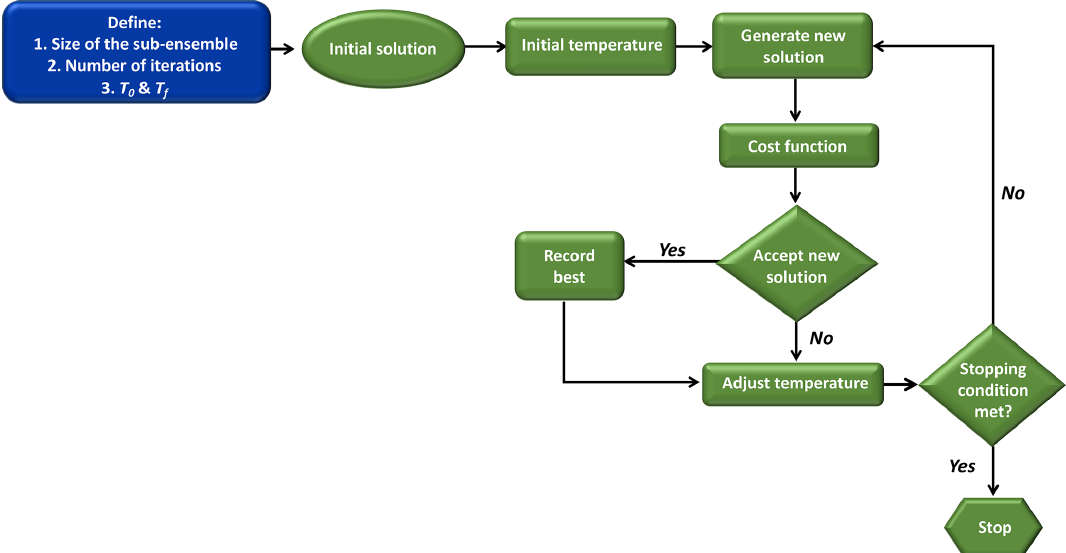
Figure A2. Diagram of the simulated annealing algorithm